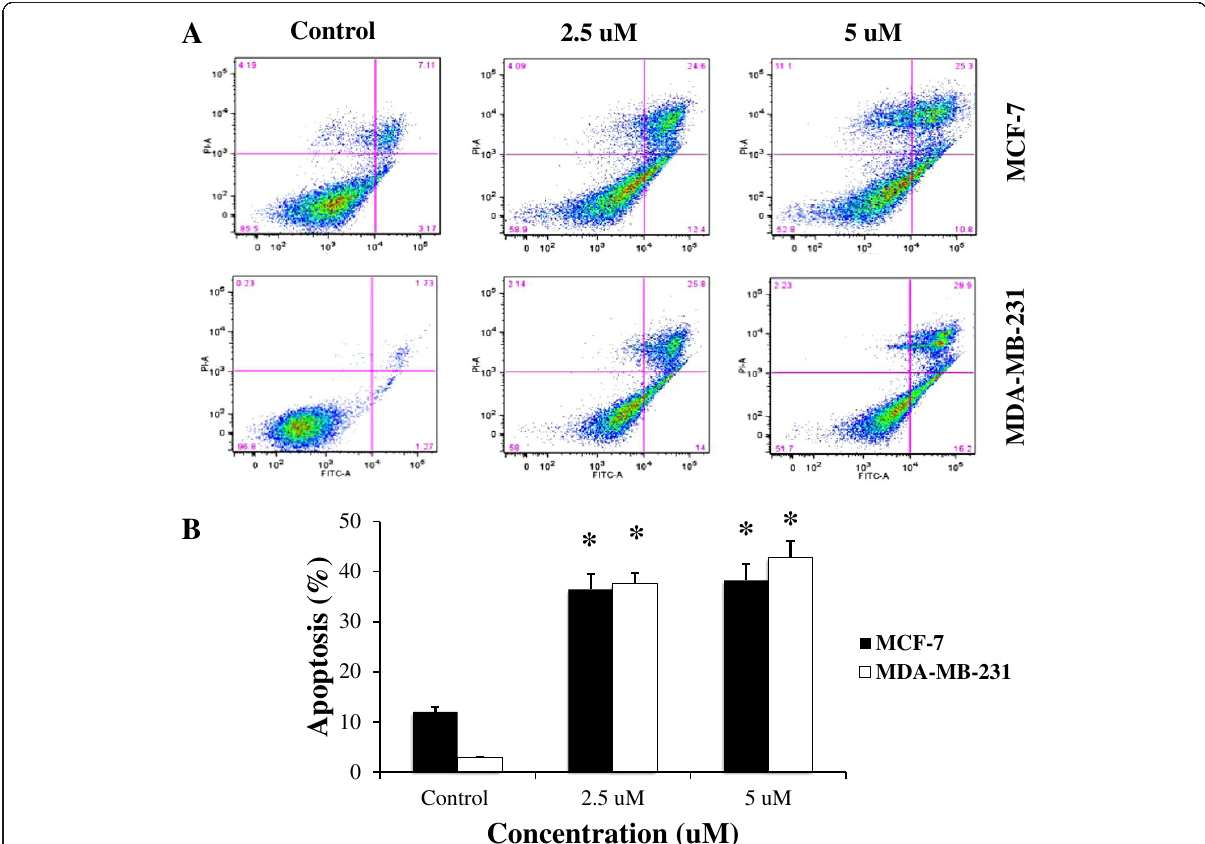
Figure 4 Apoptotic induction by cucurbitacin B. MCF-7 and MDA-MB-231 were incubated with cucurbitacin B for 24 hr and apoptosis was analyzed by Annexin V-FITC. A . Annexin V-FITC staining is represented on the X-axis and PI staining is represented on the Y-axis. B . The values indicate the percentage of apoptotic cells in each concentration. Results shown are the average of three independent experiments. *, p <0.05 (treated vs untreated control).